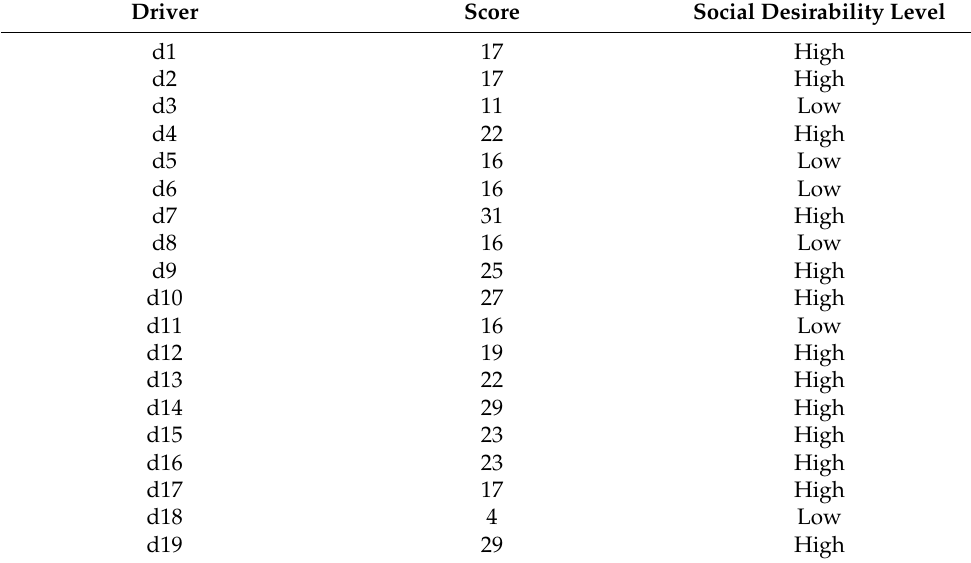
Table 4. M-C SDS responses.